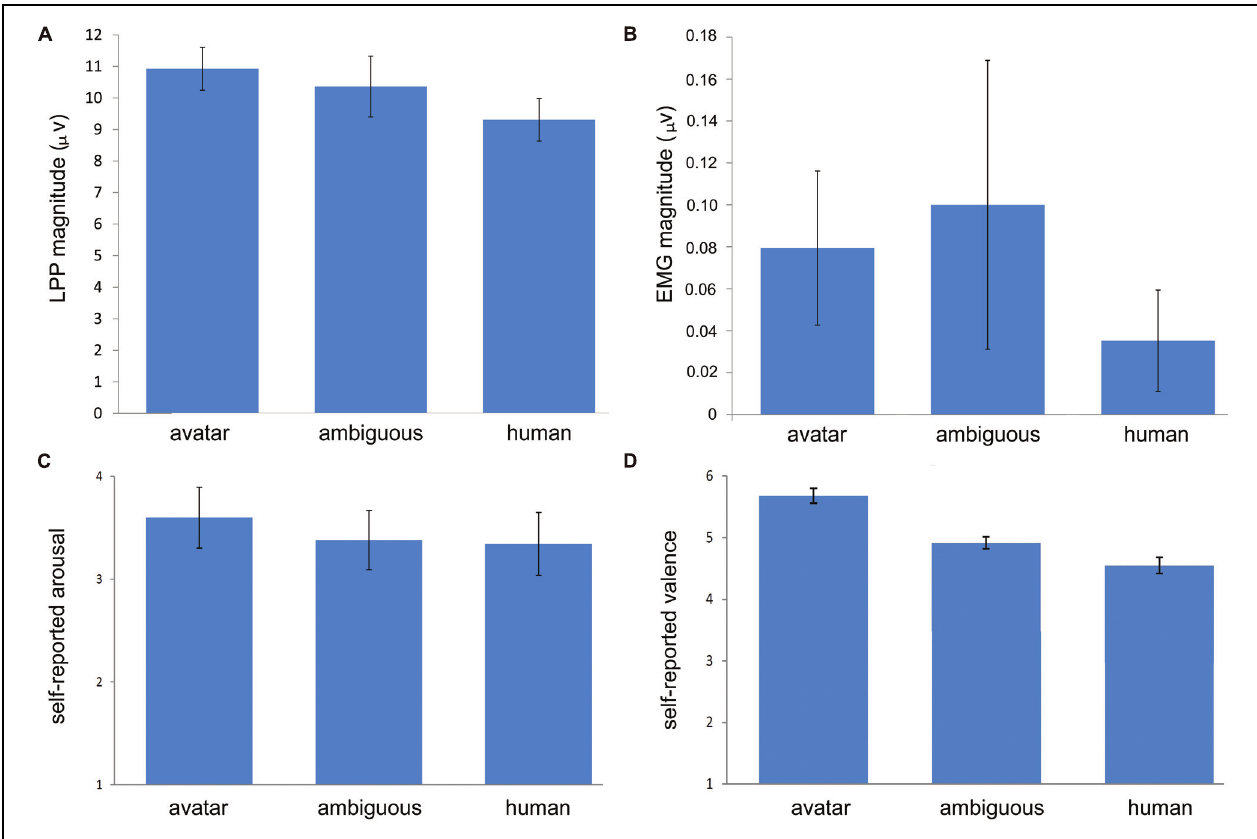
FIGURE 3 | Effect of highly unambiguously avatar and human and highly ambiguously categorized faces on arousal and valence. Overall, the figures illustrate a general increase in LPP magnitude indicating arousal (A) , in self-rated arousal (C) and in self-rated